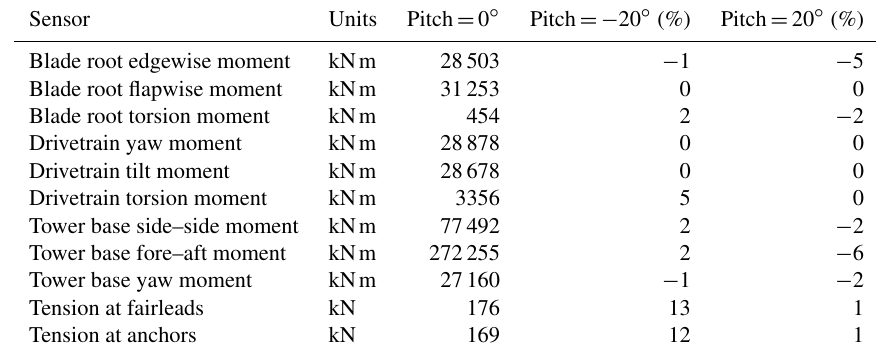
Table 5. Comparison of lifetime DELs for platform pitch angles 0 ◦ , 20 ◦ (wake-up), and − 20 ◦ (wake-down). Sensor Units Pitch = 0 ◦ Pitch =− 20 ◦ (%) Pitch = 20 ◦ (%) Blade root edgewise moment kNm 28503 − 1 − 5 Blade root flapwise moment kNm 31253 0 0 Blade root torsion moment kNm 454 2 − 2 Drivetrain yaw moment kNm 28878 0 0 Drivetrain tilt moment kNm 28678 0 0 Drivetrain torsion moment kNm 3356 5 0 Tower base side–side moment kNm 77492 2 − 2 Tower base fore–aft moment kNm 272255 2 − 6 Tower base yaw moment kNm 27160 − 1 − 2 Tension at fairleads kN 176 13 1 Tension at anchors kN 169